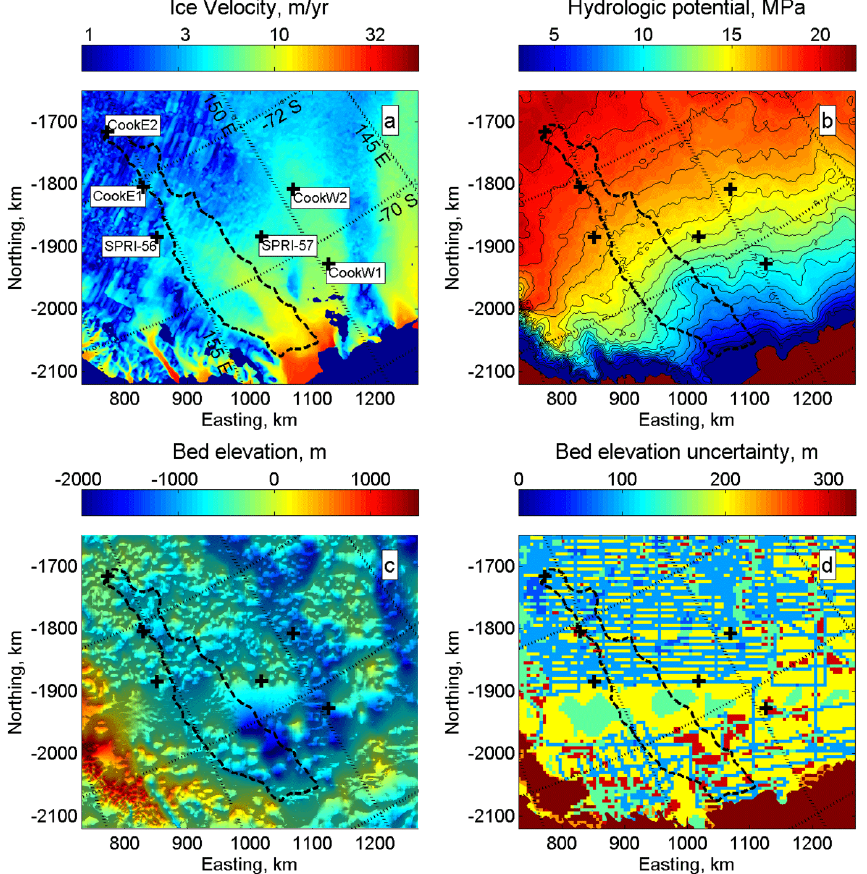
Fig. 2. (a) Ice flow velocity from Rignot et al. (2011), (b) hydrologic potential computed from BEDMAP2 (Fretwell et al., 2013), (c) shaded relief map of bed topography from BEDMAP2, and (d) bed topography uncertainty from BEDMAP2. Lakes from the Wright and Siegert (2012) inventory are localized by black crosses. The envelope of all possible subglacial water flowpaths (Sect. 3.2) is the black dashed line. The x and y axes are given in kilometres in the south polar stereographic projection (EPSG:3031).